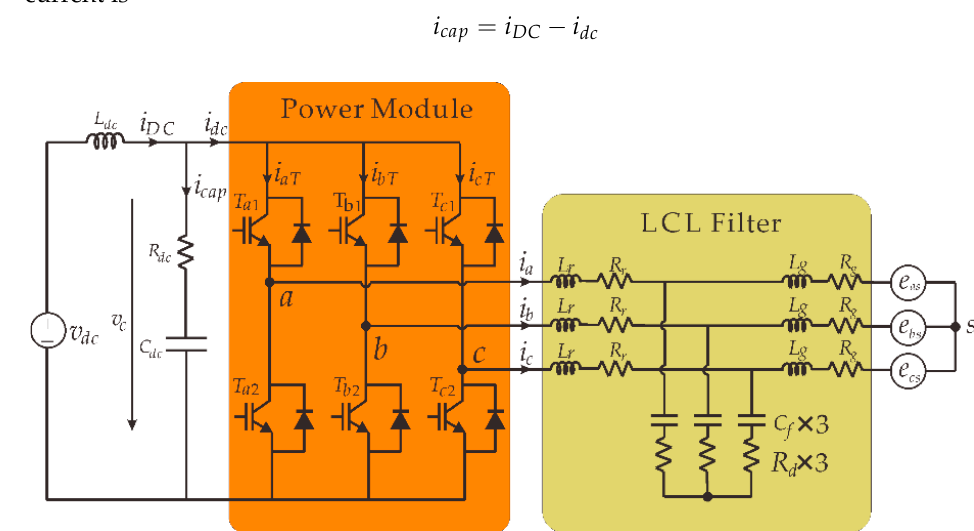
Figure 1. The typical three-phase VSC topology.